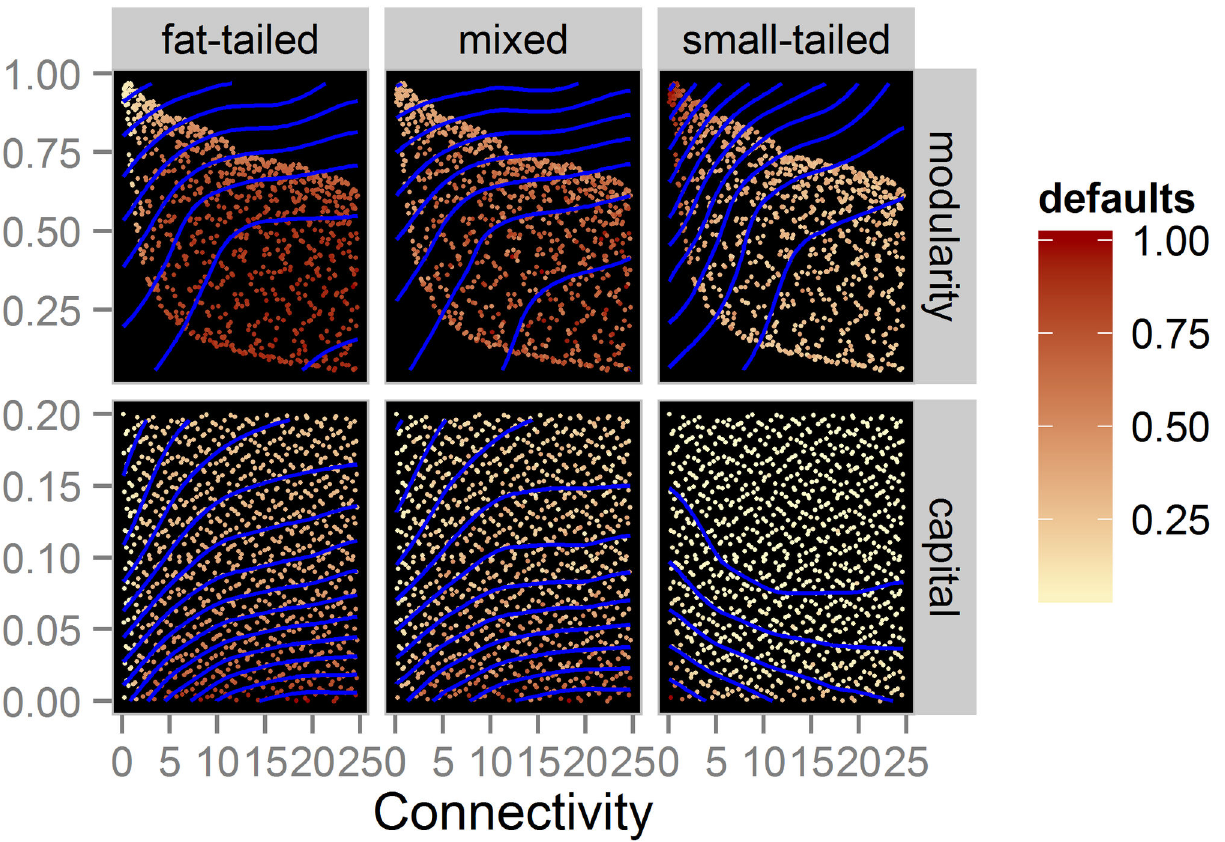
Figure 3. Effects of interactions on the number of mean defaults. The upper panel shows the interaction between connectivity and modularity, the lower panel the interaction between connectivity and level of capitalization. Blue contour lines represent the interpolation using a loess-function. Note that the number of mean defaults has been normalized for the range of each panel, and hence quantitative comparisons between panels are not